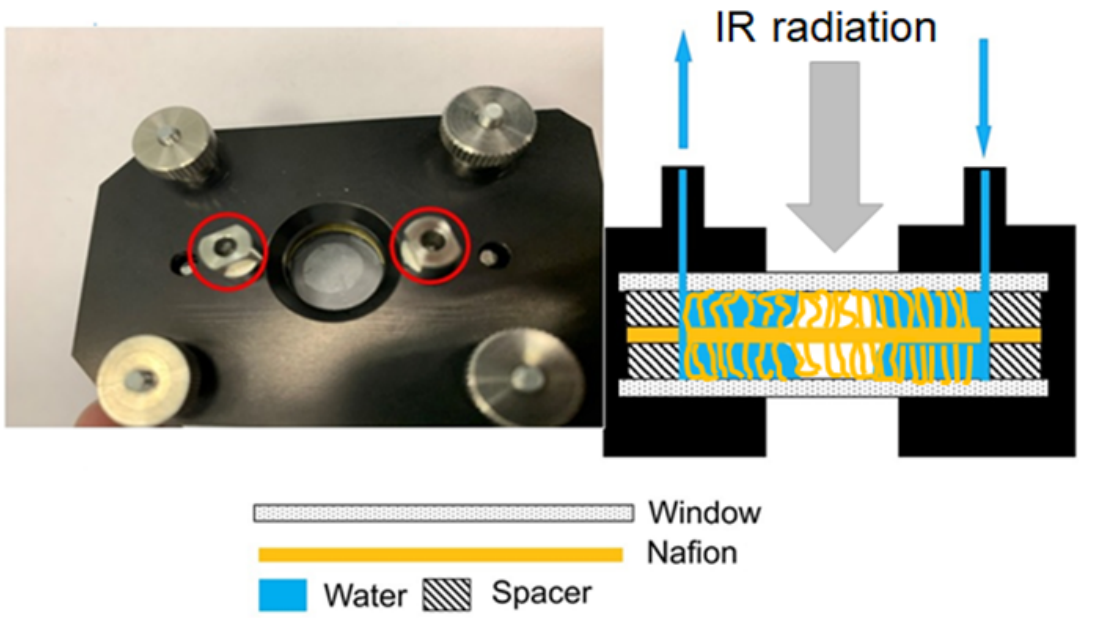
Figure 2. The cell immediately after filling with deionized water; the inlet and outlet are marked with red circles and blue arrows.